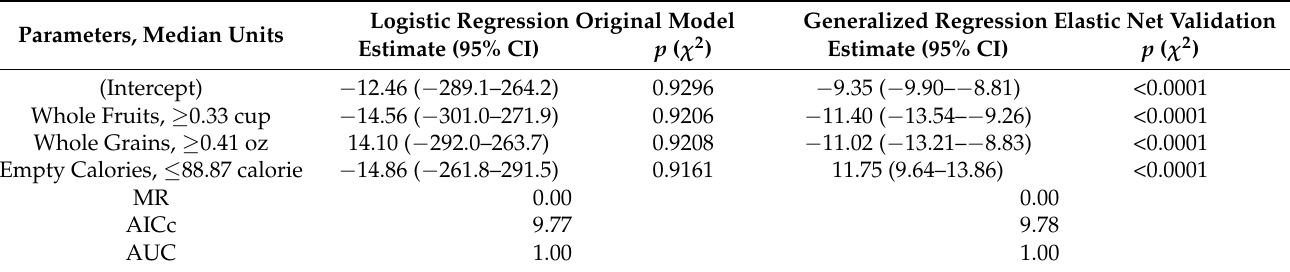
Table 2. Predictors of Healthy Eating Index (>80).